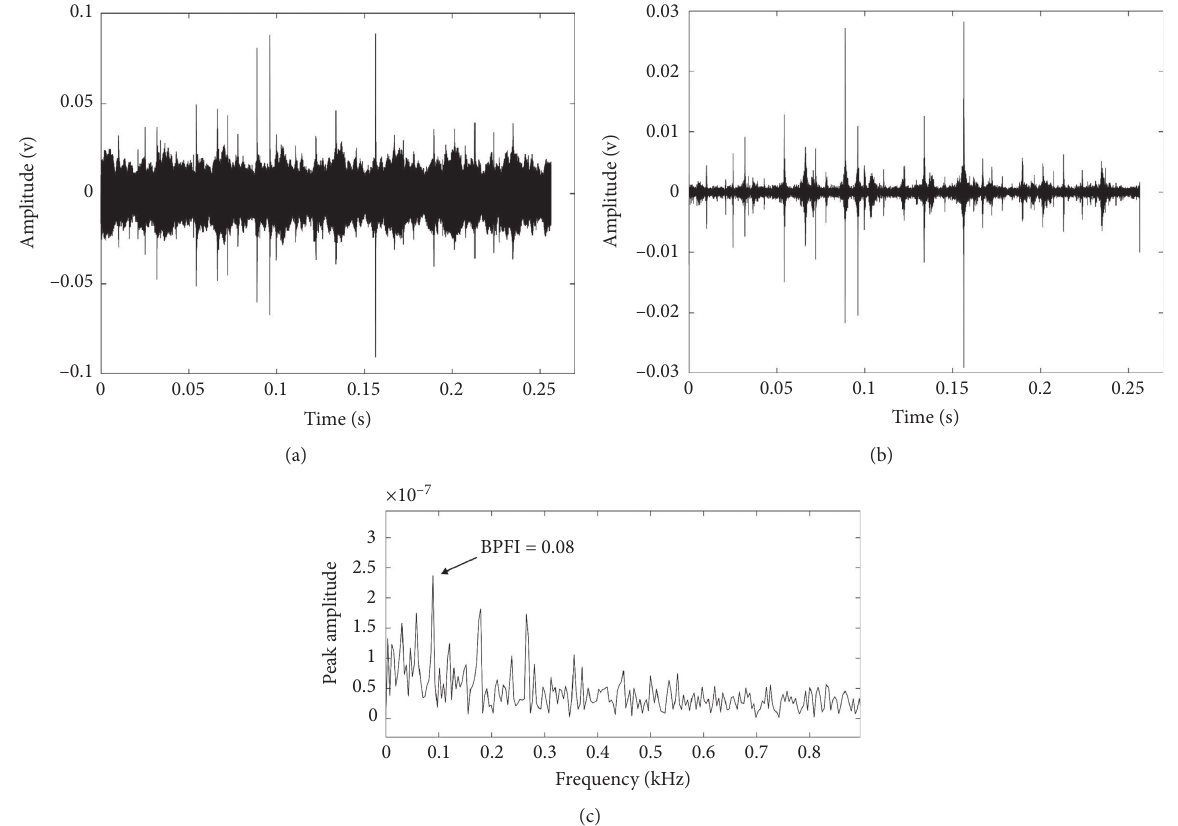
Figure 14: Fault detection on inner race. (a) Raw signal. (b) Denoised signal. (c) Envelope spectrum and fault